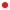
A principal component analysis of miRNA expression levels in duodenal biopsies can classify patients with NCWS and controls.(A) A principal component analysis was performed on the ΔCt values for each gene. First component (PC1) was plotted against second component (PC2) to identify genes driving the two components and to explain the percentage variation. • Control group; + NCWS group. (B) Fitted ROC curve (blue line) of the first principal component data (red dots). Plotting of the true positive rate versus false positive rate as defined by the PC1 values. AUC = 0.74 ± 0.0702 (p<0.001, Wilcoxon U test). Grey lines: 95% confidence interval of the fitted ROC curve.